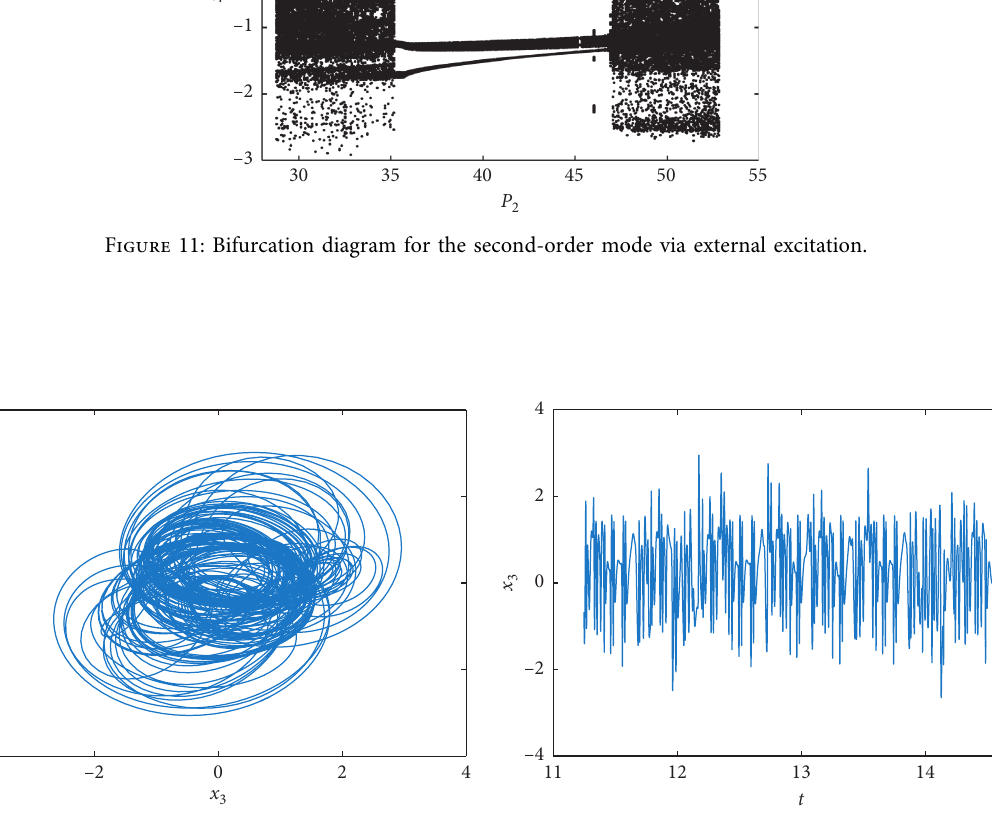
, x ) and the waveforms on the plane ( t, x 3 4